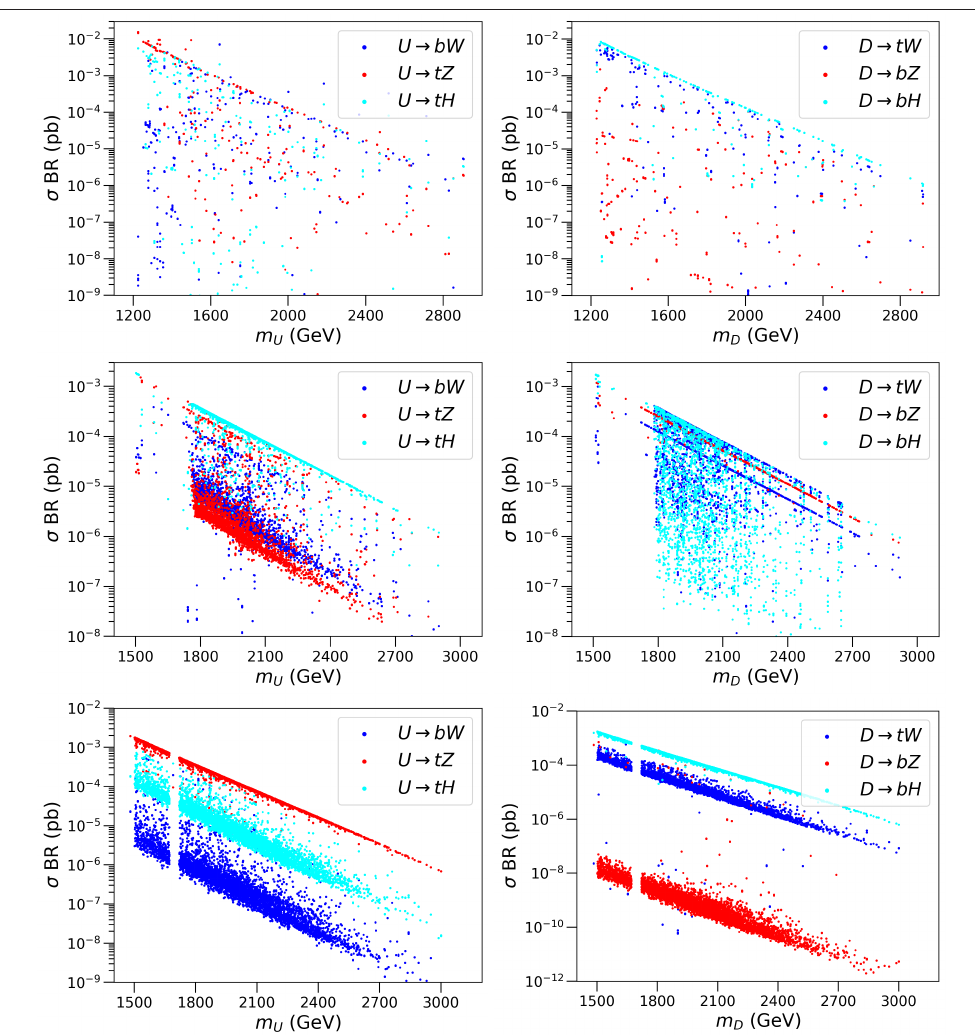
Figure 3: Cross sections for the pair-production of the lightest up-type (U) and down-type (D) resonances decaying into various final states at the in (top) the M4DCHM 5 − 5 − 5 , (middle) the M4DCHM 14 − 14 − 10 , (bottom) the M4DCHM 14 − 1 − 10